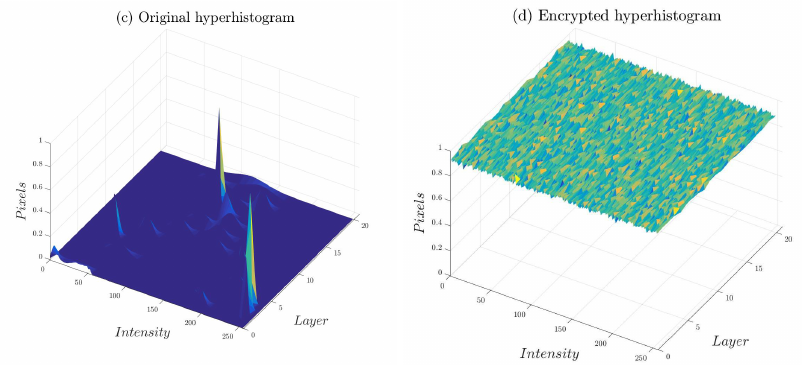
Figure 7. Original and encrypted image (layer one) of Female06 HI.